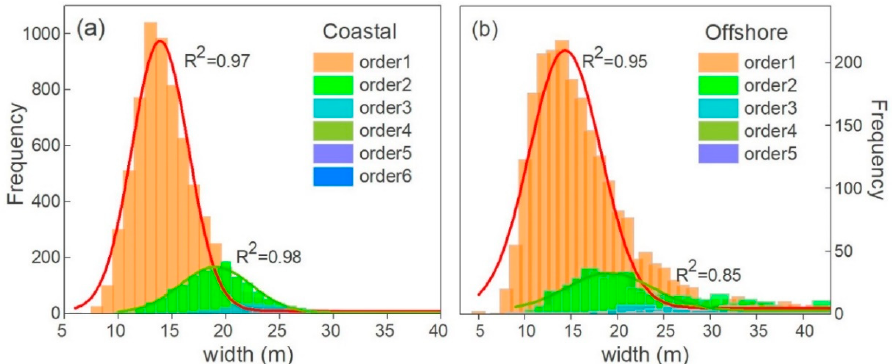
Figure 7. Frequency distributions of the widths of ( a ) coastal and ( b ) offshore tidal creeks of different order. The red and green lines are fitting curves for first-order and second-order creeks, respectively. Compared with the length and width, the depth of tidal creeks varies only slightly, mainly within the range of 0.11—0.40 m, and the difference in the tidal creek depth between different orders